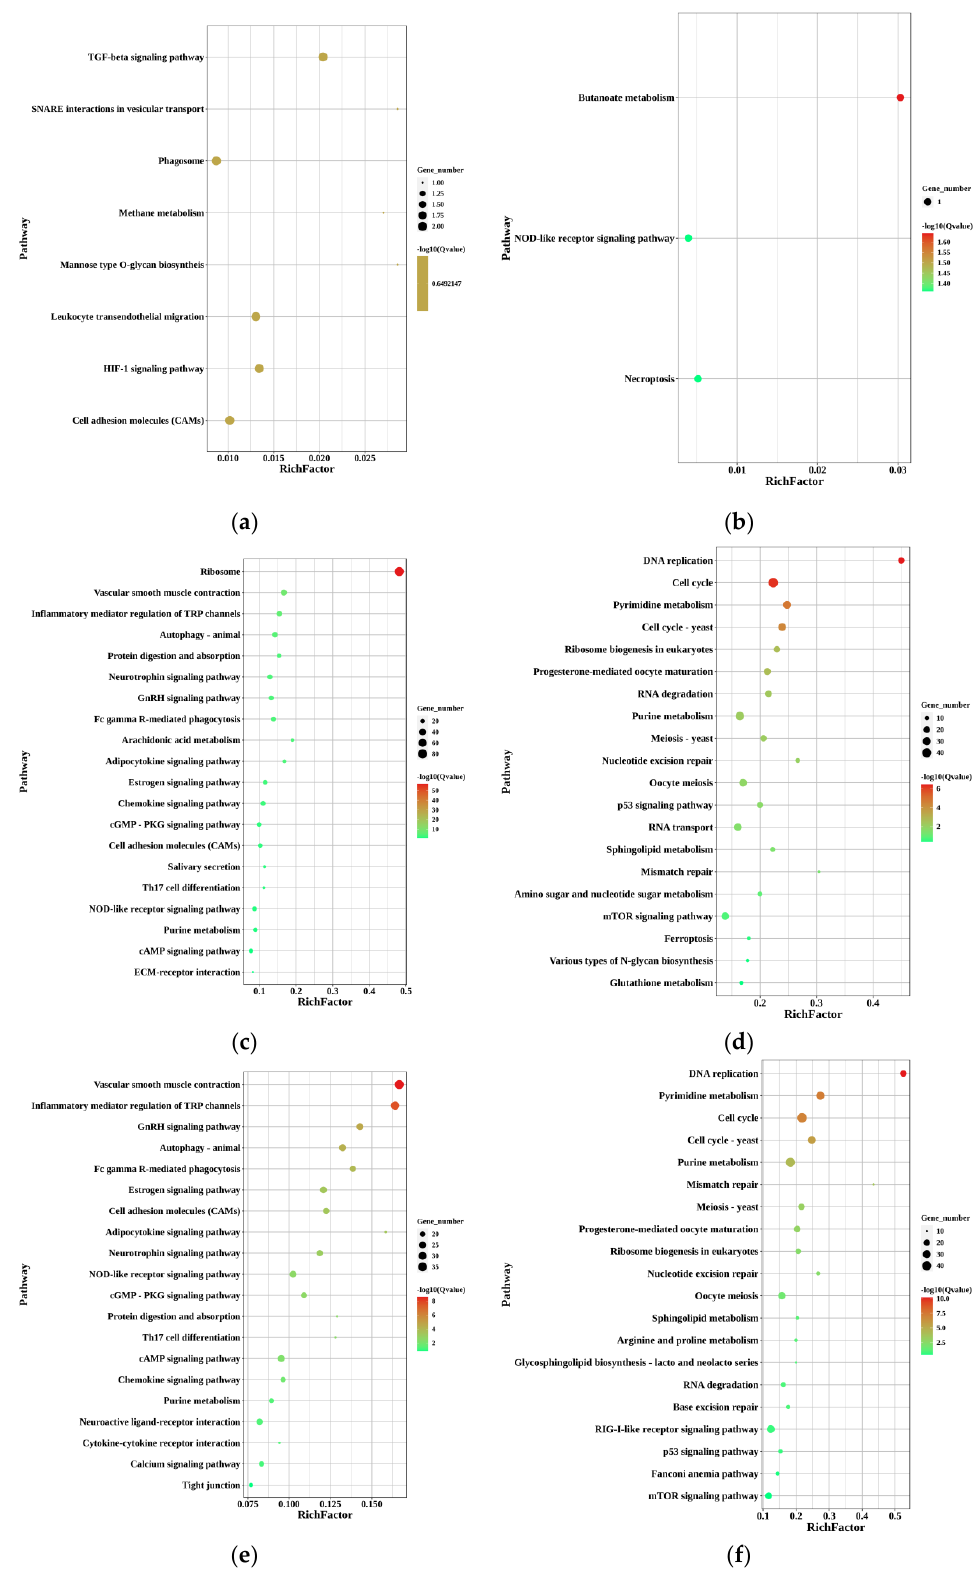
Figure 4. Enriched KEGG pathways for DEGs of MT-vs.-PMT, FO-vs.-MT, and FO-vs.-PMT. ( a ) Up- regulated DEGs of MT-vs.-PMT. ( b ) Down-regulated DEGs of MT-vs.-PMT. ( c ) Up-regulated DEGs of FO-vs.-MT. ( d ) Down-regulated DEGs of FO-vs.-MT. ( e ) Up-regulated DEGs of FO-vs.-PMT. ( f ) Down-regulated DEGs of FO-vs.-PMT. In the KEGGs enrichment of up-regulated DEGs in MT-vs.-PMT, phagosome (ko04145), TGF-beta signaling pathway (ko04350), HIF-1 signaling pathway (ko04066), cell adhesion molecules (ko04514), and leukocyte transendothelial migration (ko04670) were the five pathways enriched with the most genes, with two genes each. In the KEGGs enrichment of down-regulated DEGs in MT-vs.-PMT, butanoate metabolism (ko00650), necroptosis (ko04217), and NOD-like receptor signaling pathway (ko04621) were the four pathways enriched with the most genes, with one gene each. In the KEGGs enrichment of up-regulated DEGs in FO-vs.-MT, ribosome (ko03010), vascular smooth muscle contraction (ko04270), inflammatory mediator regulation of TRP channels (ko04750), autophagy—animal (ko04140), and neurotrophin signaling pathway (ko04722) were the five pathways enriched with the most genes, with 80, 37, 31, 29, and 25 genes, respectively. In the KEGGs of down-regulated DEGs in FO-vs.-MT, cell cycle (ko04110), purine metabolism (ko00230), pyrimidine metabolism (ko00240), cell cycle— yeast (ko04111), and oocyte meiosis (ko04114) were the five pathways enriched with the most genes, with 44, 35, 29, 28, and 27 genes, respectively.